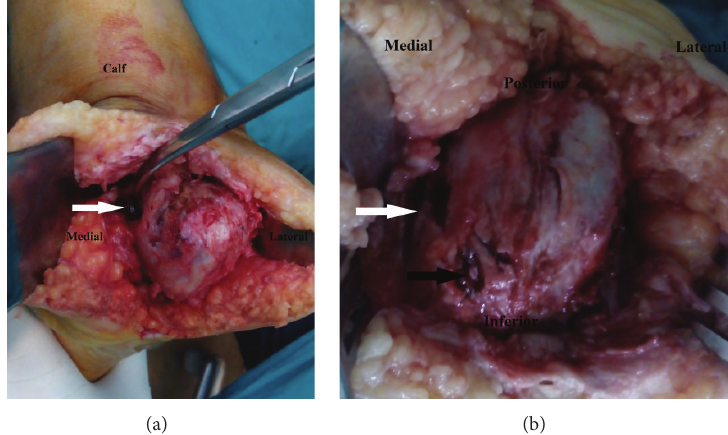
Figure 2: (a) Intraoperative images of calcaneus employing the heel splitting approach. Note the conglomerate of black grains arising from the cavity on the medial surface of calcaneus (white arrow). (b) Intraoperative images of calcaneus employing the heel splitting approach. Note the large medial cavity (white arrow) and cortical erosion covered by minute black grains (black